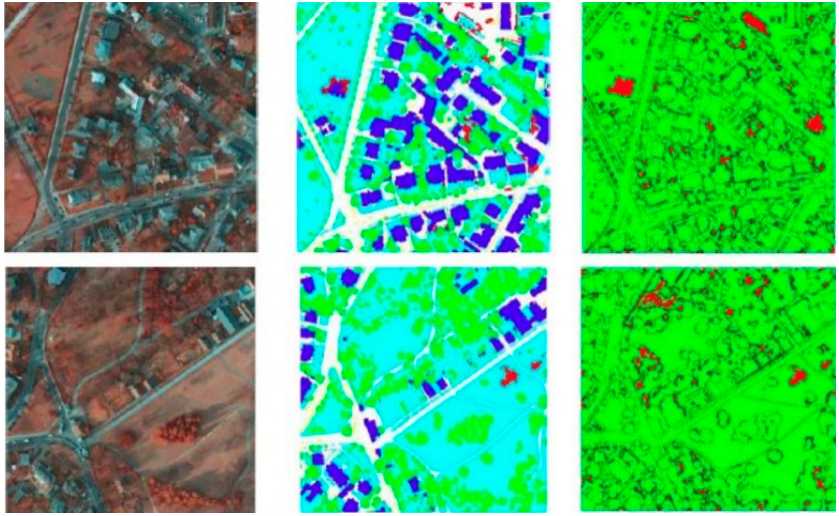
Figure 5. Qualitative segmentation results of our method and other competing methods.